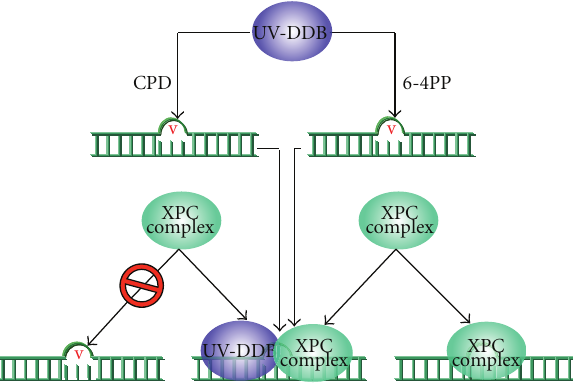
Figure 12: Di ff erent pathway for recognition of DNA lesions such as CPD and 6-4PP. In case of CPD photoproduct (cause little distortion), XPC complex binds to the lesion after recruitment of UV-DDB whereas 6-4PP that distorts the DNA helix to a great extent can be recognized either by interacting with prebound UV- DDB or directly by XPC